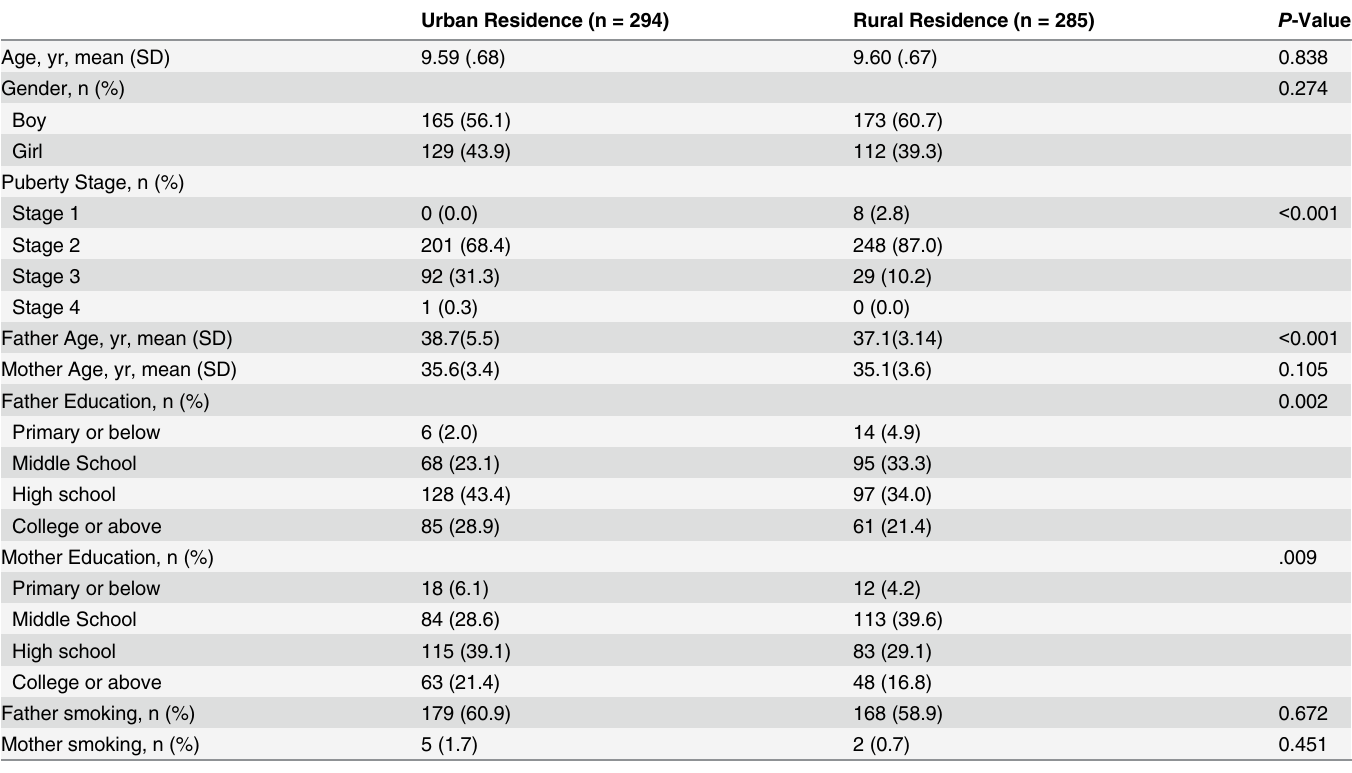
Table 1. Characteristics of the participants a